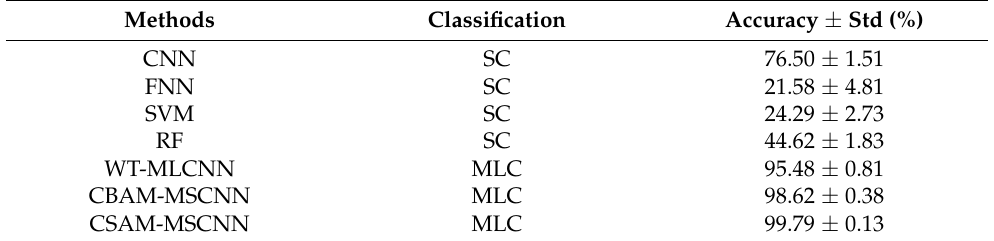
Table 5. Mean test accuracy and standard deviation of the proposed method versus other methods.